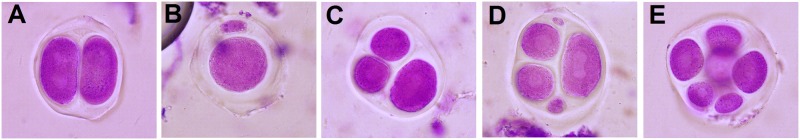
The normal and abnormal meiosis behavior of Gossypium herbaceum × G. raimondii F1 hybrid.A) Normal dyad. B) Unequal separation of dyad. C) Non-synchronized division of dyad in meiosis II. D) Unequal division with various abnormal micronuclei. E) Abnormal polyads.